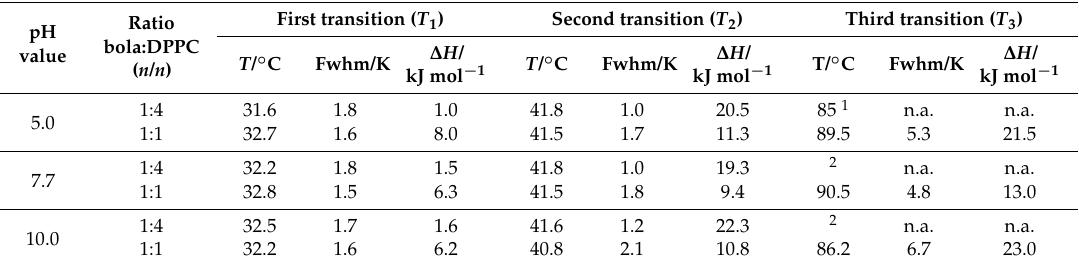
Table 2. DSC data of Me 2 PE-Gly(2C16)C32-OH :DPPC mixtures ( c = 3 mM) at various pH values using different buffer systems ( c = 10 mM; acetate buffer at pH = 5.0, phosphate buffer at pH = 7.7, carbonate buffer at pH = 10.0); data are taken from the second heating scan (heating rate 60 K h −1 ).